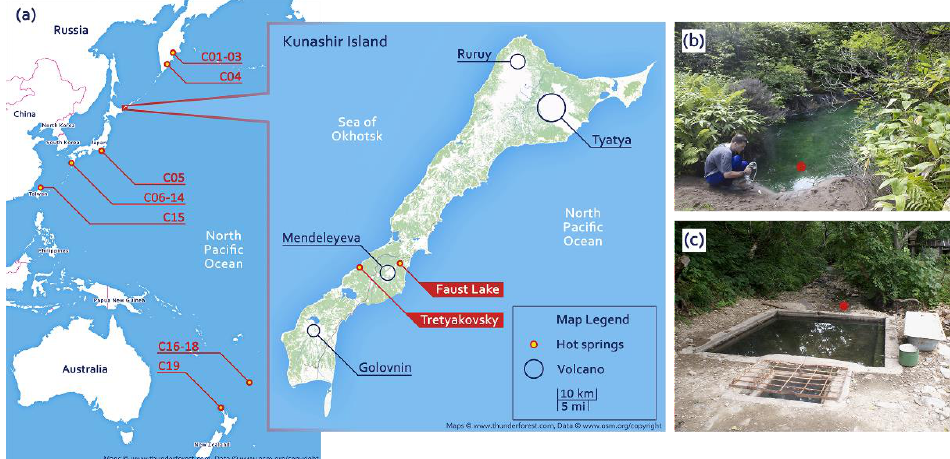
Figure 1. ( a ) The map of the locations of the investigated hot springs and ( b , c ) photographs of sampling sites: ( b ) Faust Lake (FAU) and ( c ) the Tretyakovsky Spring (TRT).